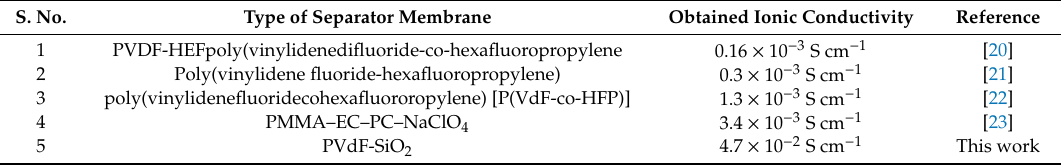
Table 2. Comparison of ionic conductivity of prepared PVdF-SiO 2 membrane with previous reports. S.